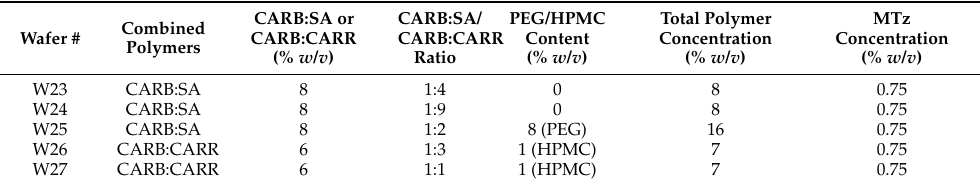
Table 4. Drug loaded (DL) composite CARB:SA and CARB:CARR gels at different concentrations and ratios with or without